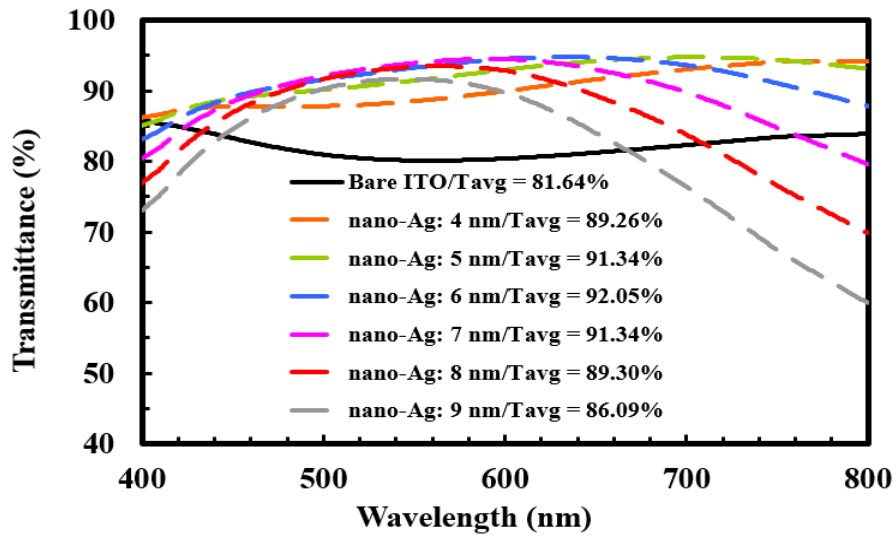
Figure 2. The average optical transmittance (T avg ) simulation for ITO/nano-Ag/ITO multilayer films relates to different nano-Ag films thickness (from 4 to 9 nm) while keeping the 42 nm thickness of each ITO